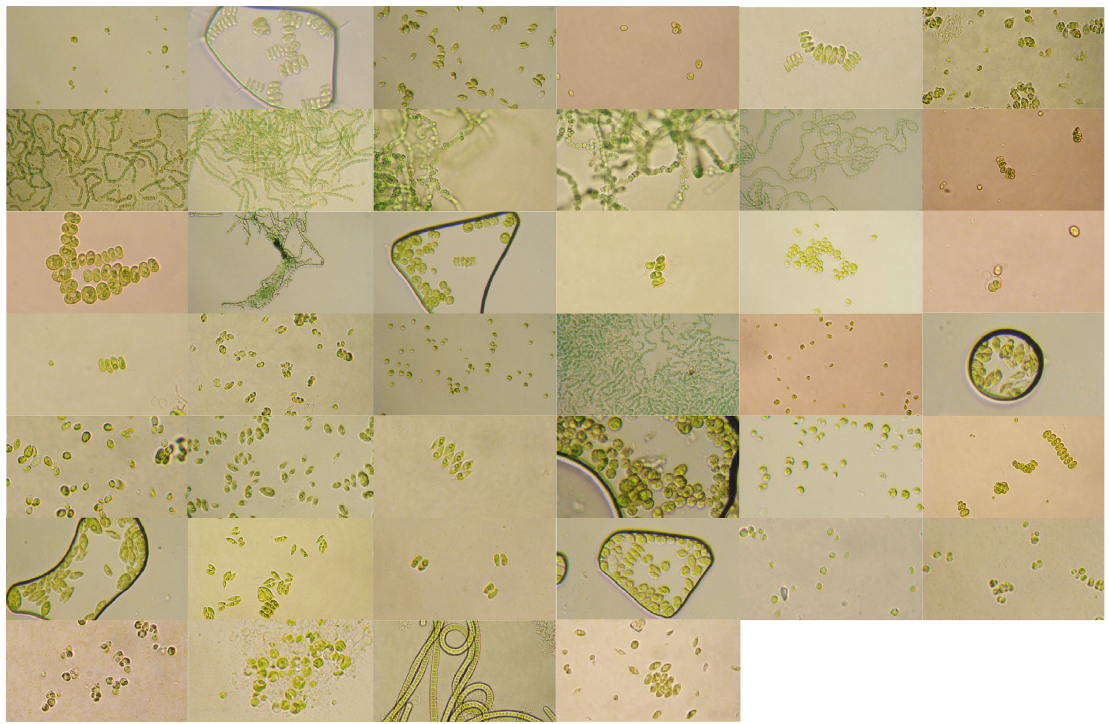
Figure 2: Light microscopy photograph of all isolated microalgal strains using a 40 X microspore